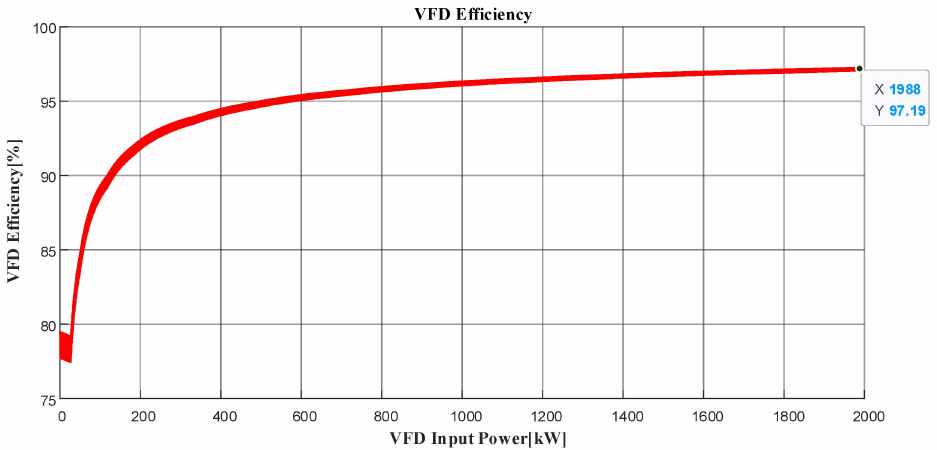
Figure 26. VFD inverter efficiency graph according to the input